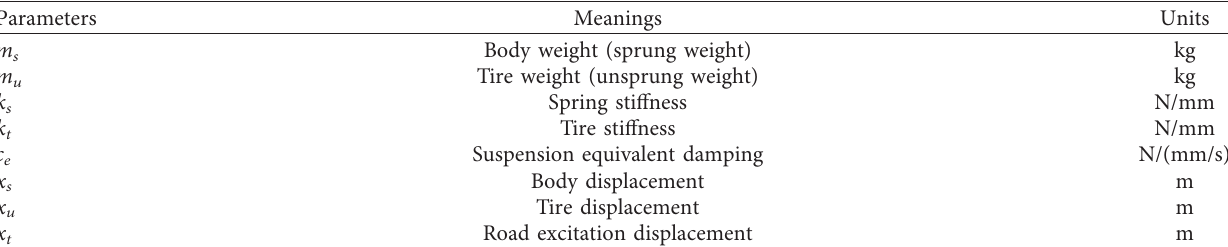
Figure 5: Suspension system vertical dynamics model. Table 2: Semiactive suspension